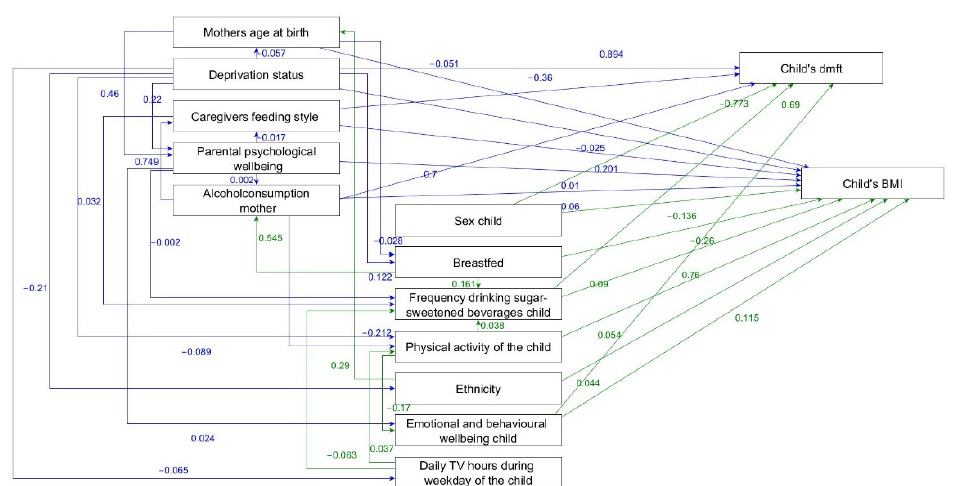
Figure 2. Parsimonious model of the adapted framework of the social determinants of dental caries and overweight/obesity in children indicating the direct effects non-standardised ß-coefficients.